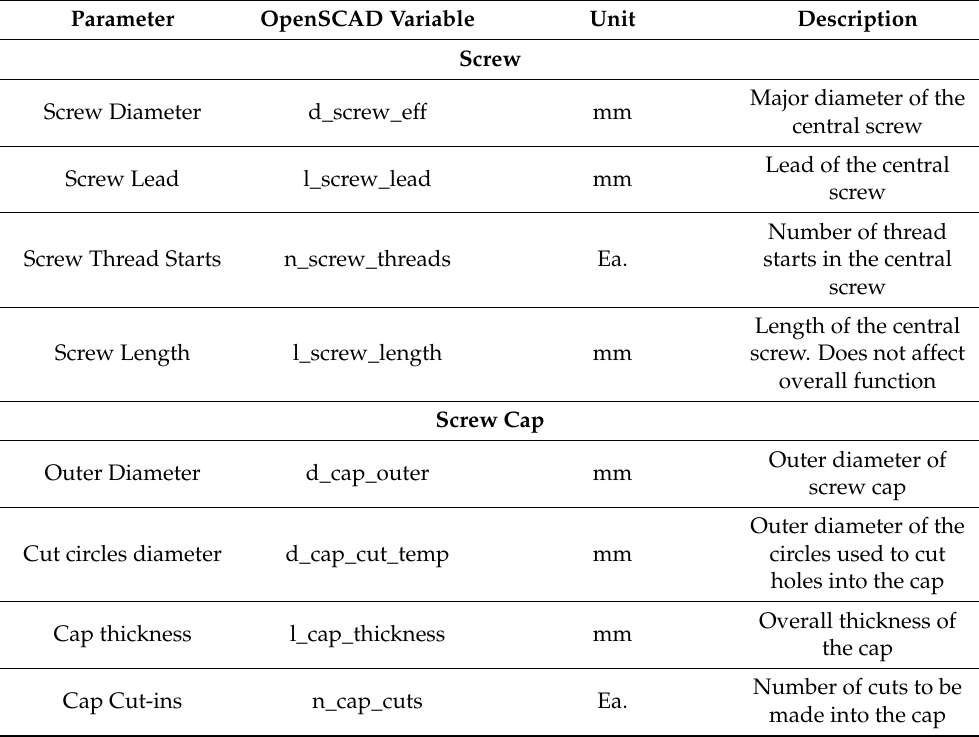
Table A3. OpenSCAD central screw